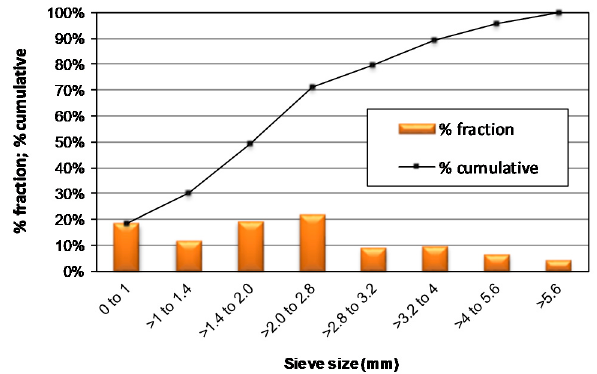
Figure 5. Granulometric analysis of BSG dried.